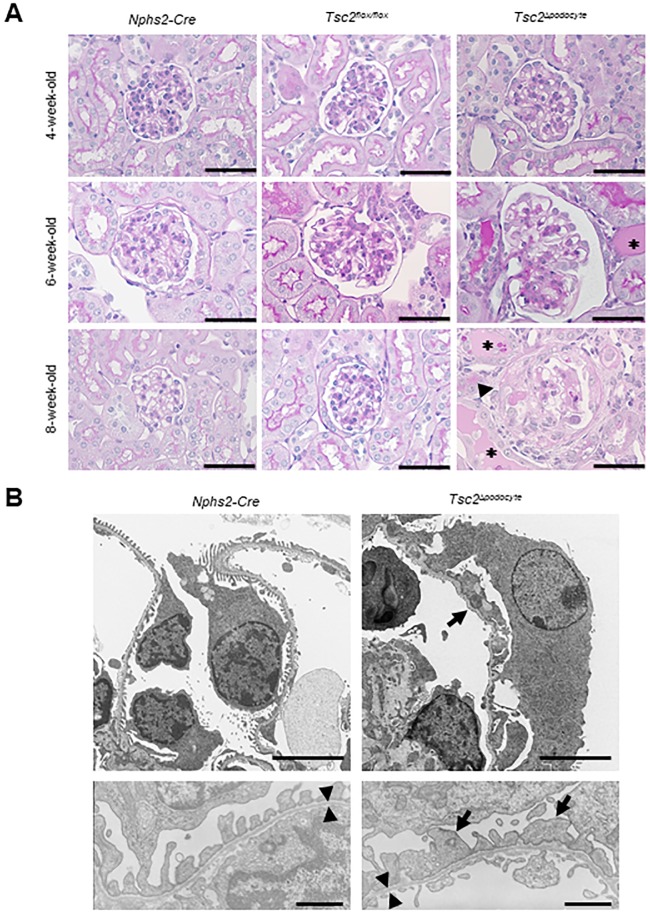
mTORC1 activation in podocytes resulted in progressive glomerulosclerosis.(A) Tsc2Δpodocyte developed progressive glomerulosclerosis between 4 and 8 weeks of age. Renal tissues from Tsc2Δpodocyte and control mice at 4, 6, and 8 weeks of age were stained with periodic acid-Schiff (PAS). Representative glomeruli from Tsc2Δpodocyte and control mice are shown. Various degrees of glomerulosclerosis, partial glomerulosclerosis and protein casts in tubules (asterisks), and glomerulosclerosis with synechia formation (arrowhead) are shown. Scale bar: 50 μm. (B) Transmission electron microscopy (TEM) shows partial flattening and disorganization of podocyte foot processes (arrows). Scale bar: 5 μm. (B, bottom) Glomerular basement membrane thickness in Tsc2Δpodocyte at 4 weeks of age was comparable with that in age-matched control mice (within arrowheads). Scale bar: 1 μm.